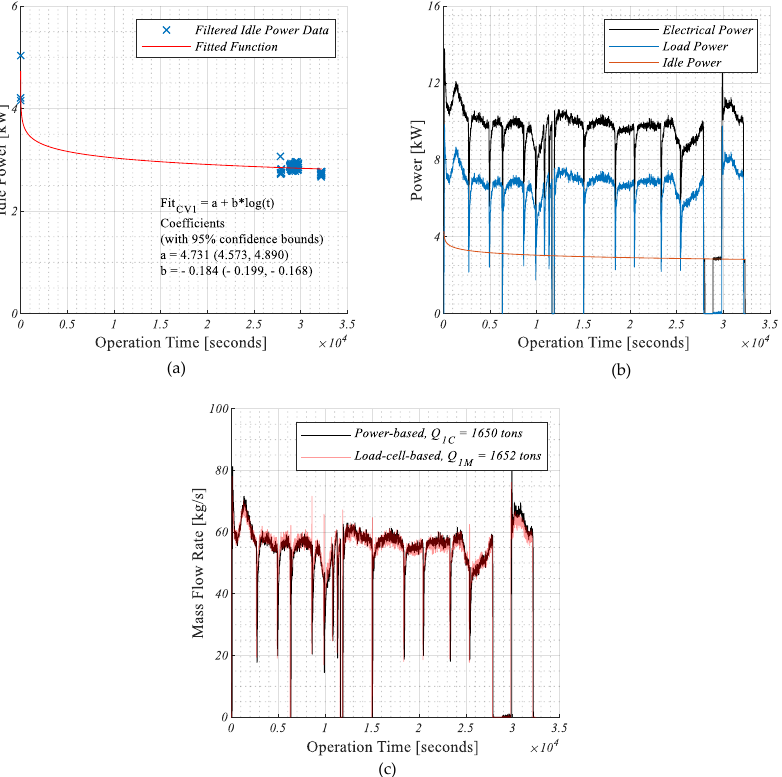
Figure 4. ( a ) Model fitting in idle power data set for conveyor CV 1 , ( b ) Calculated load power signal for conveyor CV 1 , ( c ) Calibrated power-based mass flow rate signal for conveyor CV 1 .